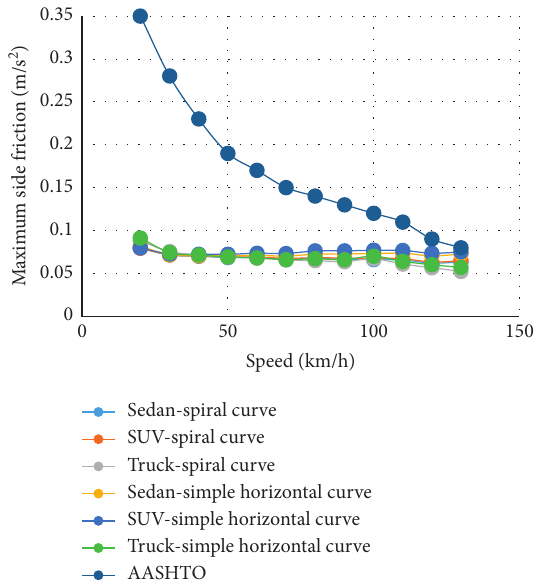
Figure 7: Maximum side friction coefficients versus the speed in the spiral and simple horizontal curves for radius R